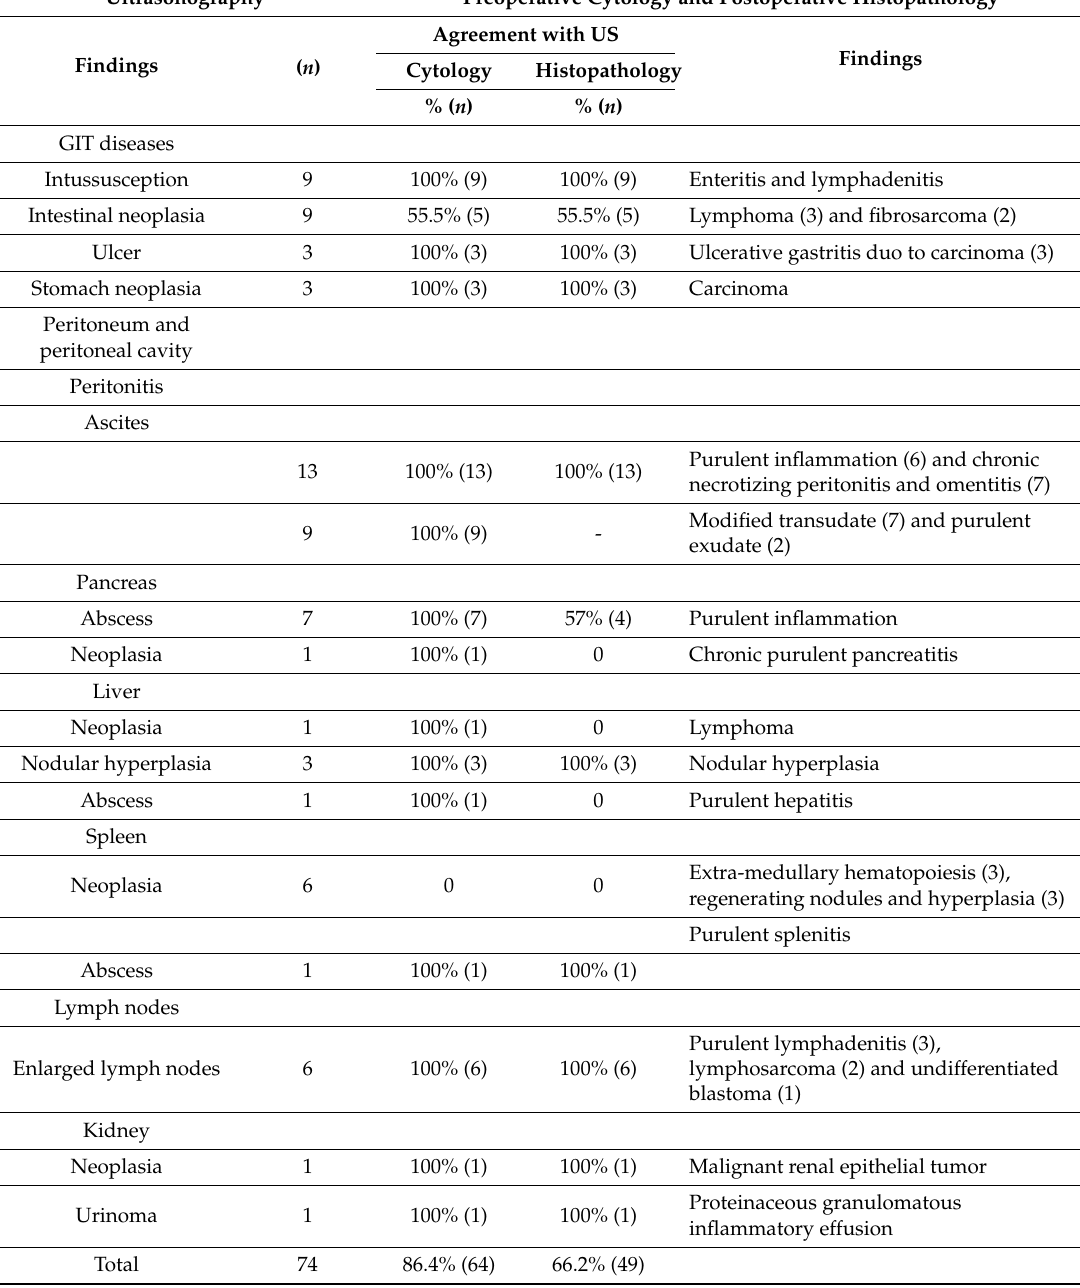
Table 3. Comparison of ultrasonographic findings with cytopathologic and histopathologic findings. Agreement between the tests is presented as a percentage (%) and number ( n ) of reported ultrasonographic lesions with cytologic or histopathologic